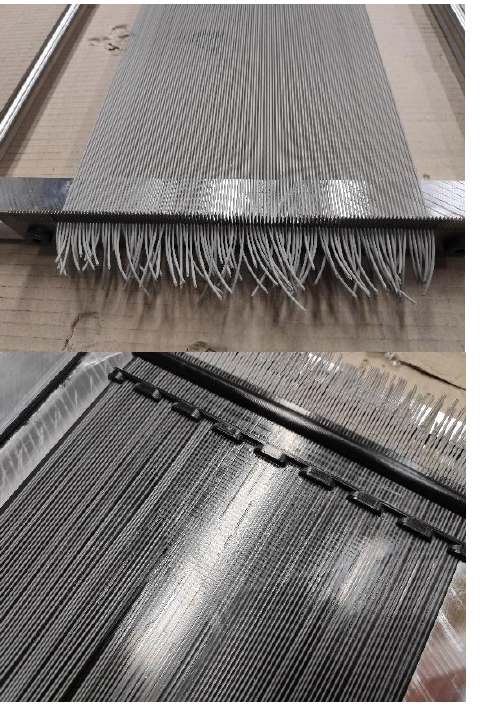
Fig. 6. Parallel fibers before the RIM process at the top and the final planar heat exchanger at the